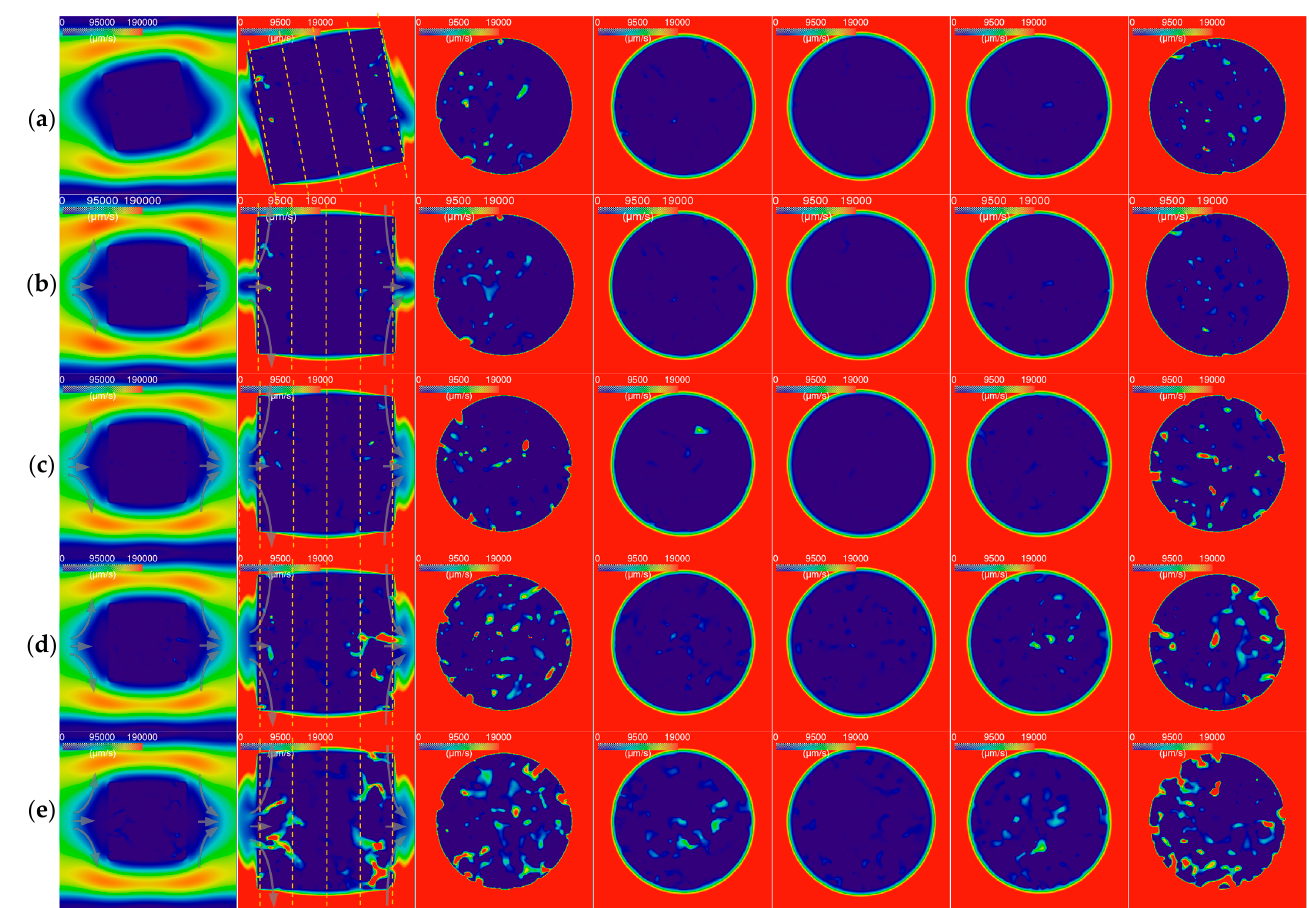
Figure 14. Gas velocity distributions for right cylinder graphite specimens: ( a ) as-received with rotation; ( b ) as-received; ( c ) oxidized for 4 min; ( d ) oxidized for 8 min; ( e ) oxidized for 24 min.